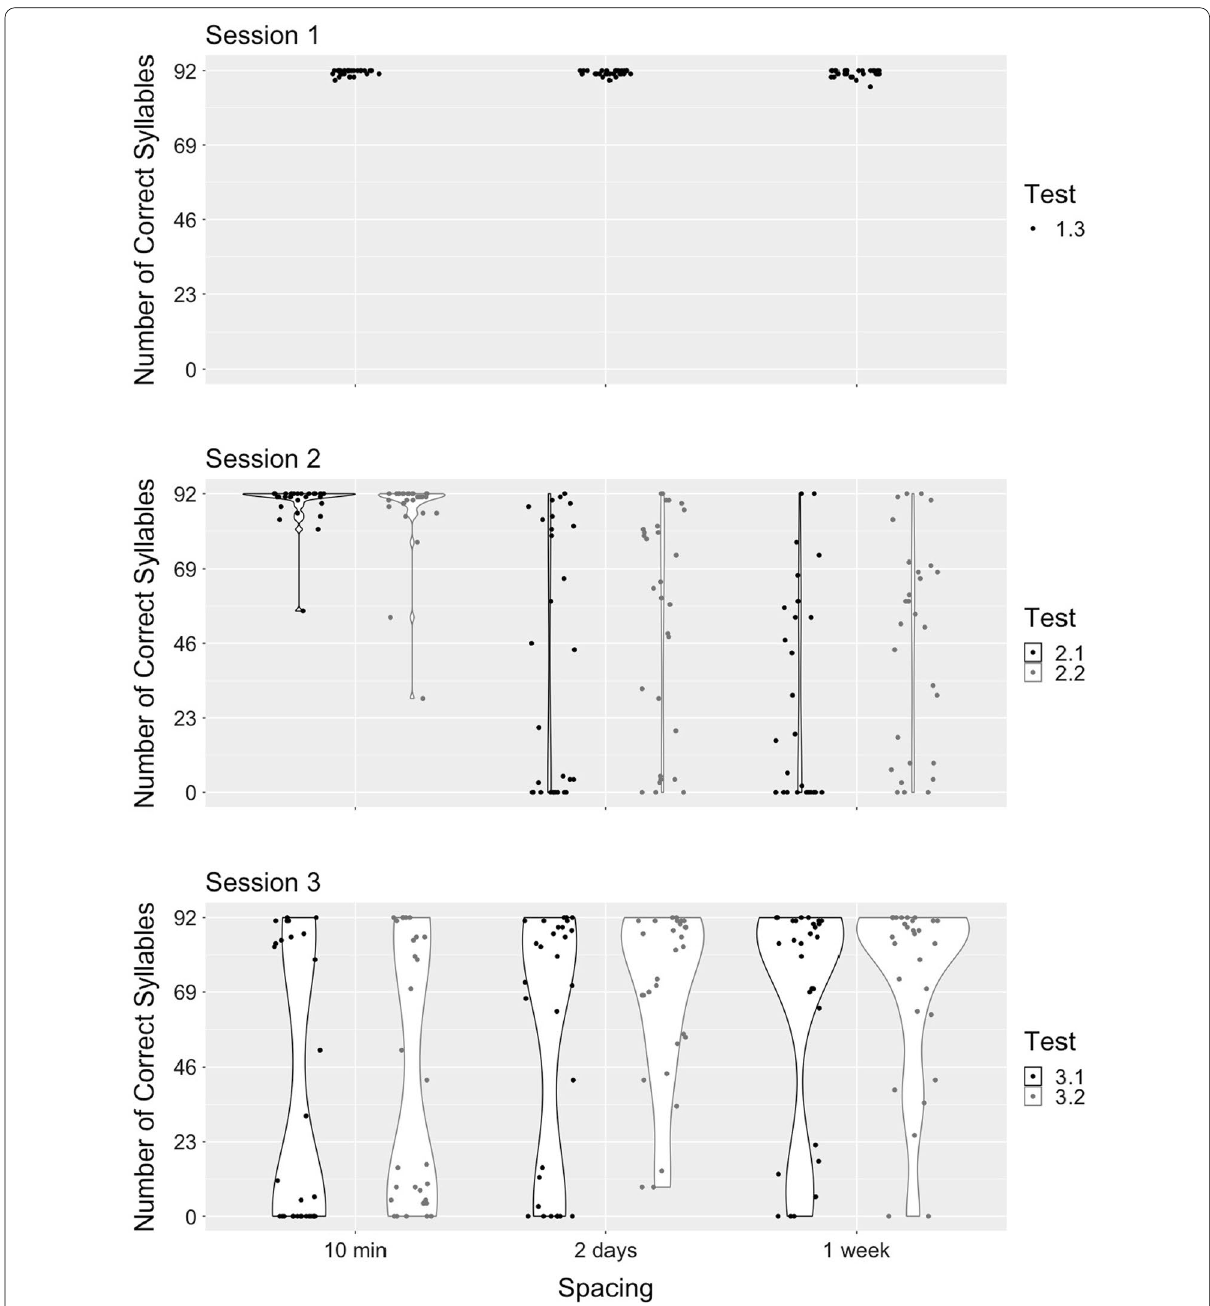
Fig. 1 Number of correct syllables (test 1: cued by notes; test 2: cued by notes and